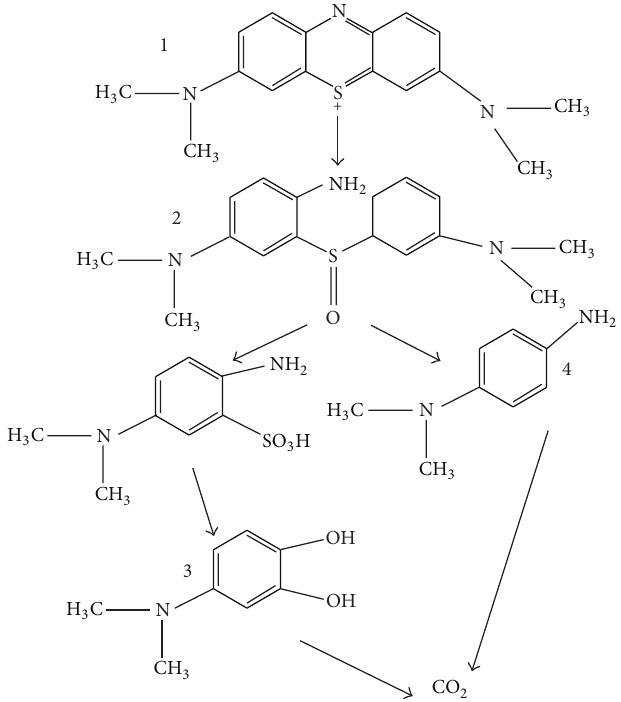
Scheme 1: Photocatalytic degradation pathway of